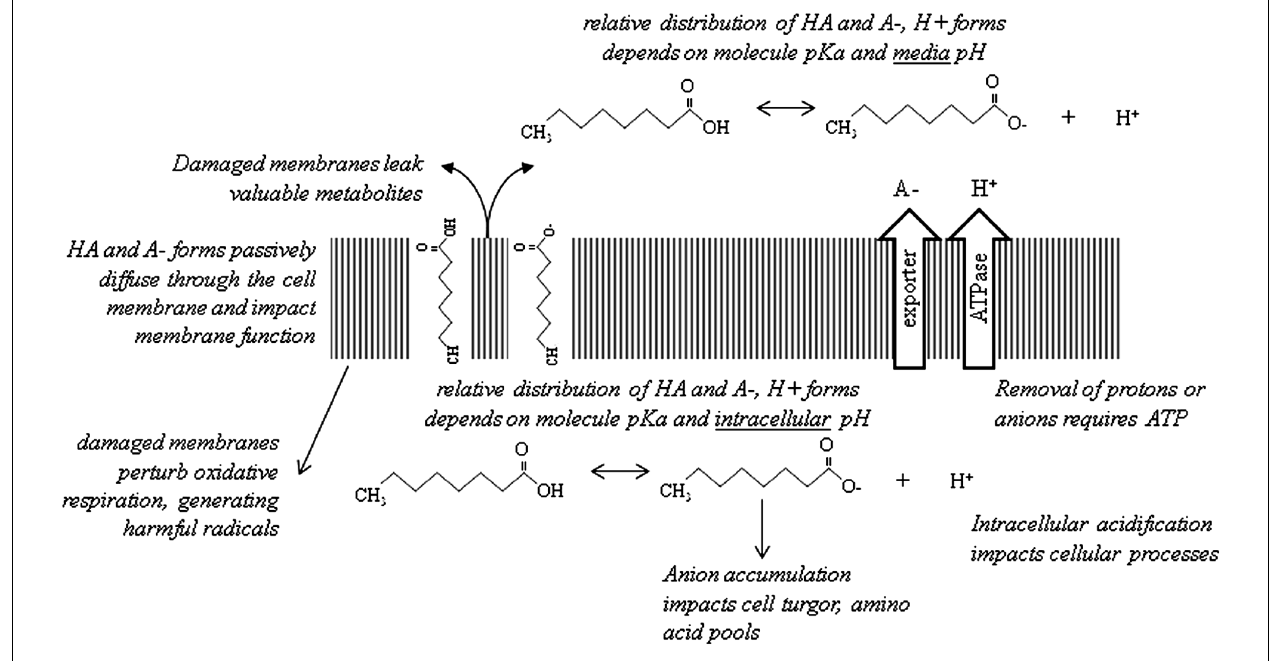
FIGURE 1 | Summary of the major mechanisms of carboxylic acid toxicity discussed in this article. For simplicity, the cell wall/membrane(s) are shown as a single structure. Octanoic acid (C8) is used as a representative carboxylic acid.